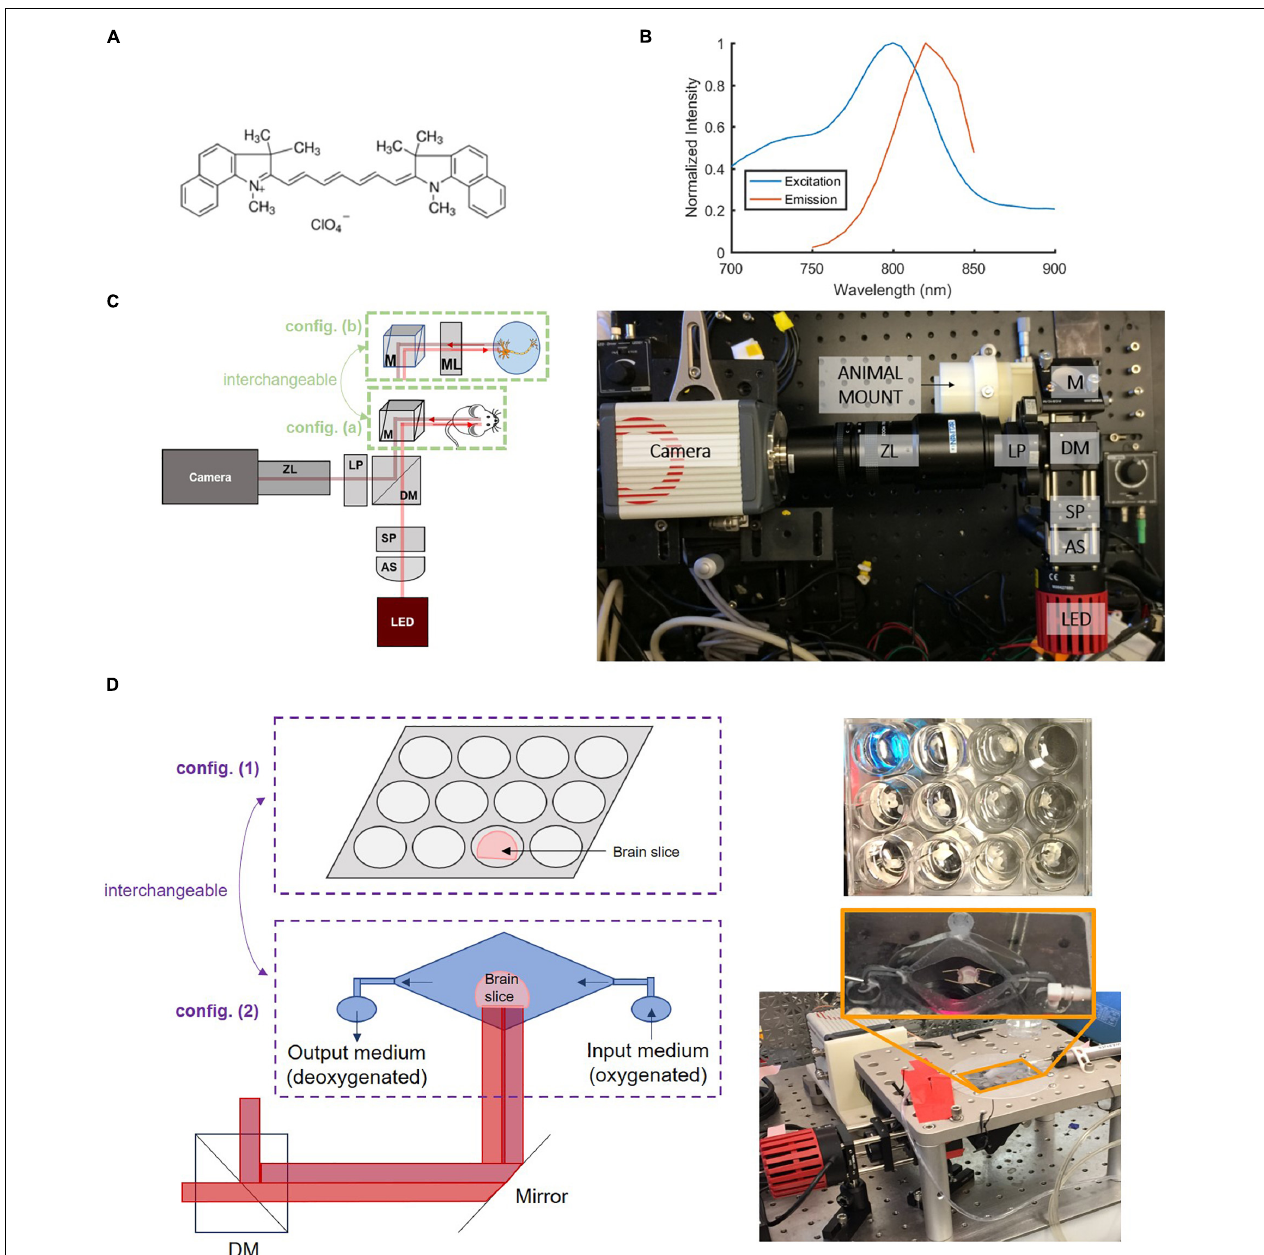
FIGURE 1 | Near-IR VSD IR-780 perchlorate’s (A) chemical structure and (B) excitation-emission characteristics collected by spectrophotometry, which informed the (C) design of the versatile wide-field fluorescence imaging system with two configurations: config. (a) for larger field of view and config. (b) for greater magnification to achieve cellular resolution for in vitro experiments. B : Adapted with permission from Pak et al. (2018) © The Optical Society. AS = aspheric lens, SP = shortpass filter, DM = dichroic mirror, LP = longpass filter, ZL = zoom lens, M = mirror, ML = magnifying lens. (D) Samples were also monitored in two configurations for ex vivo brain slice studies: config. (1) a well plate setup and config. (2) a “bath” with continuous flow of new oxygenated medium to promote improved cell